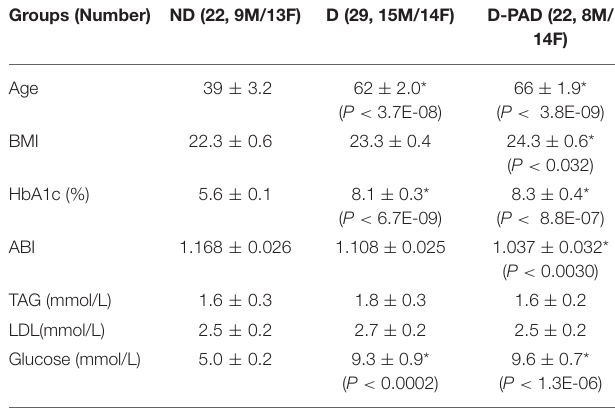
TABLE 2 | Baseline anthropometric and plasma parameters of subjects in D-PAD, D, or ND groups collected after fasting for